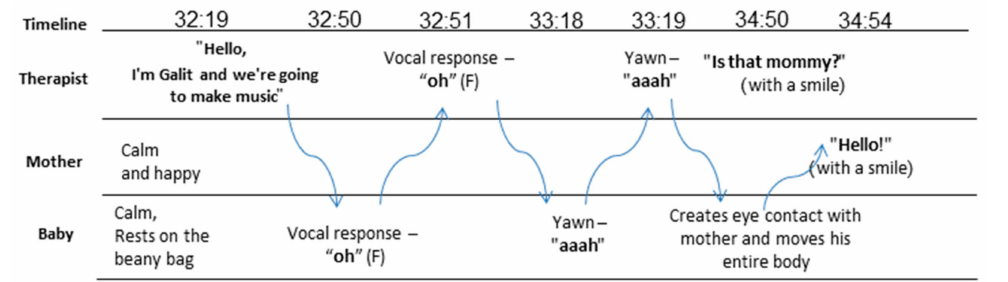
Figure 1. An illustration of a mother–baby music therapist vocal